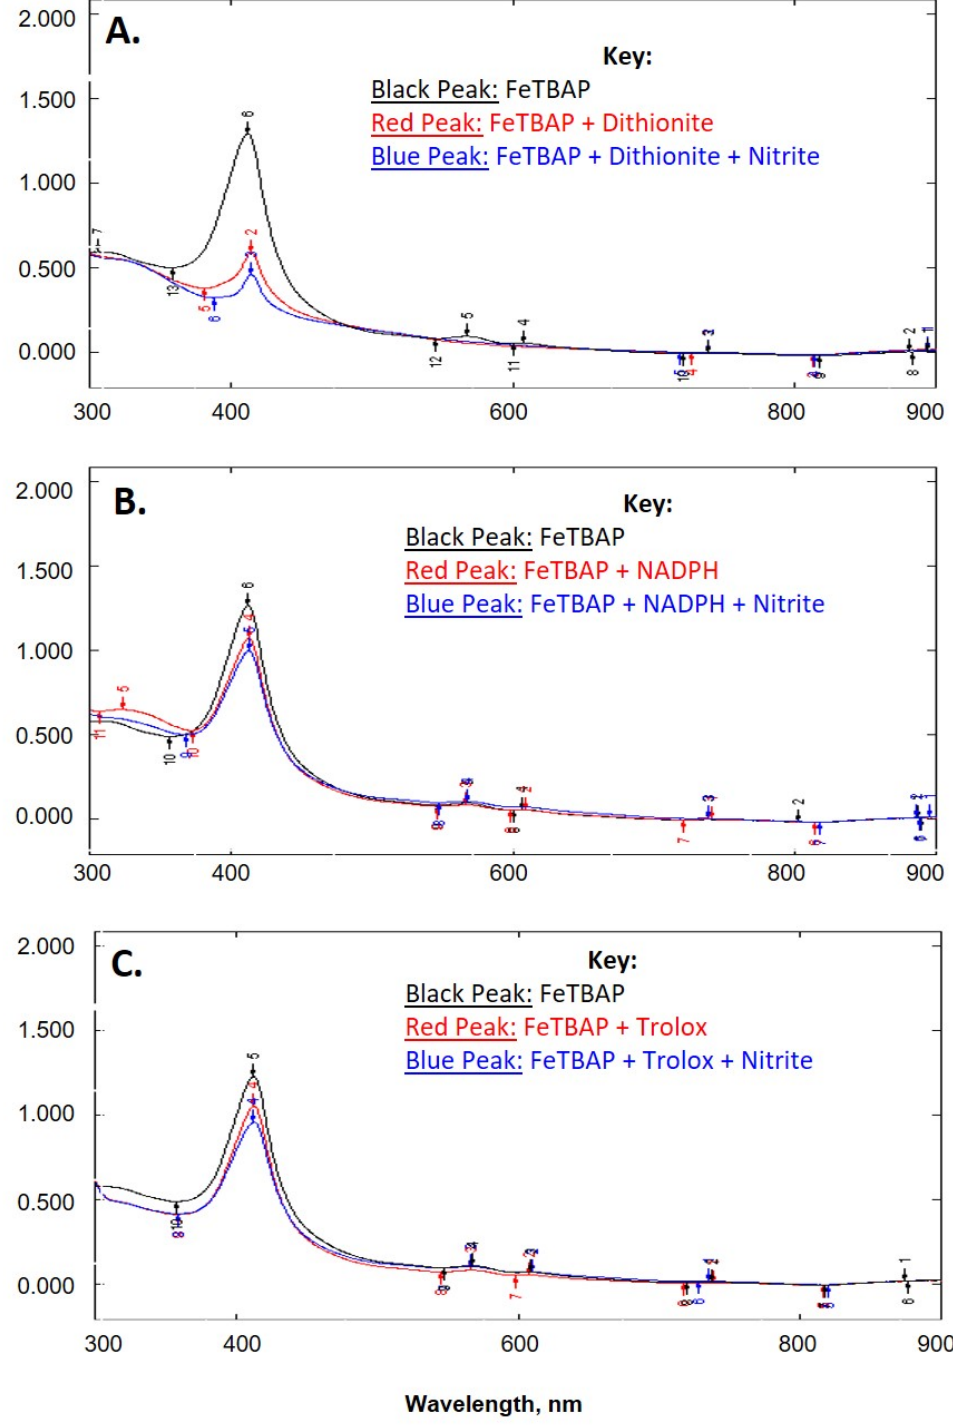
Figure 1. Decreased Soret band absorbance upon reduction is not reversed by nitrite. Absorbance spectra were obtained for 20 µ M FeTBAP (black), FeTBAP after addition of reducing compounds (( A ). 100 µ M dithionite, ( B ). 100 µ M NADPH, ( C ). 100 µ M Trolox; red), and after addition of 200 µ M nitrite to reduced FeTBAP